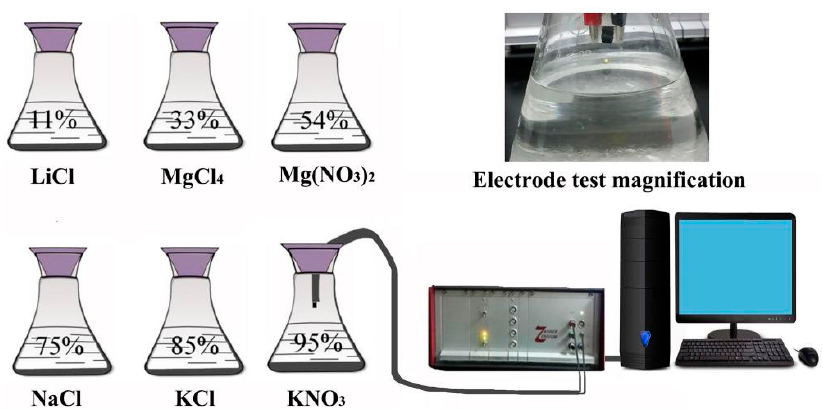
Figure 1. The diagram of humidity sensor measurement system.